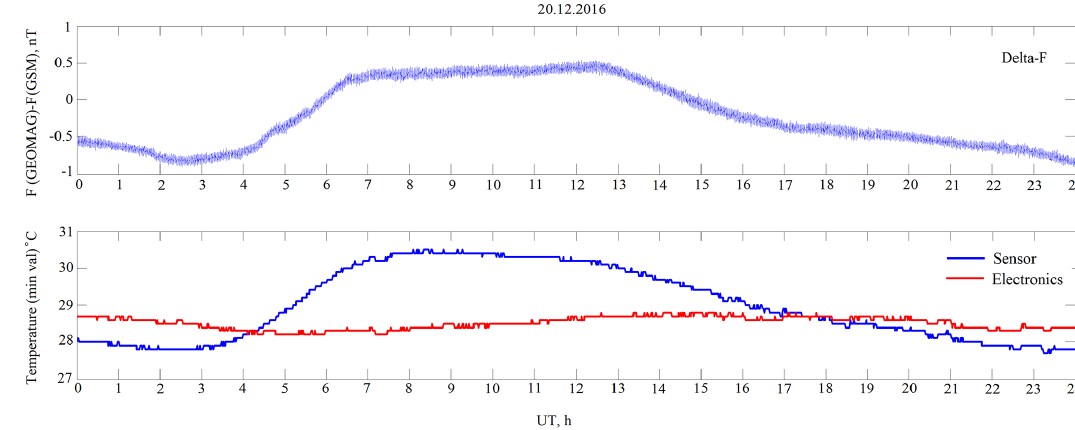
Figure 10. Example plot showing the influence of sensor–electronics temperatures on (cid:49)F observed on 20 December 2016.